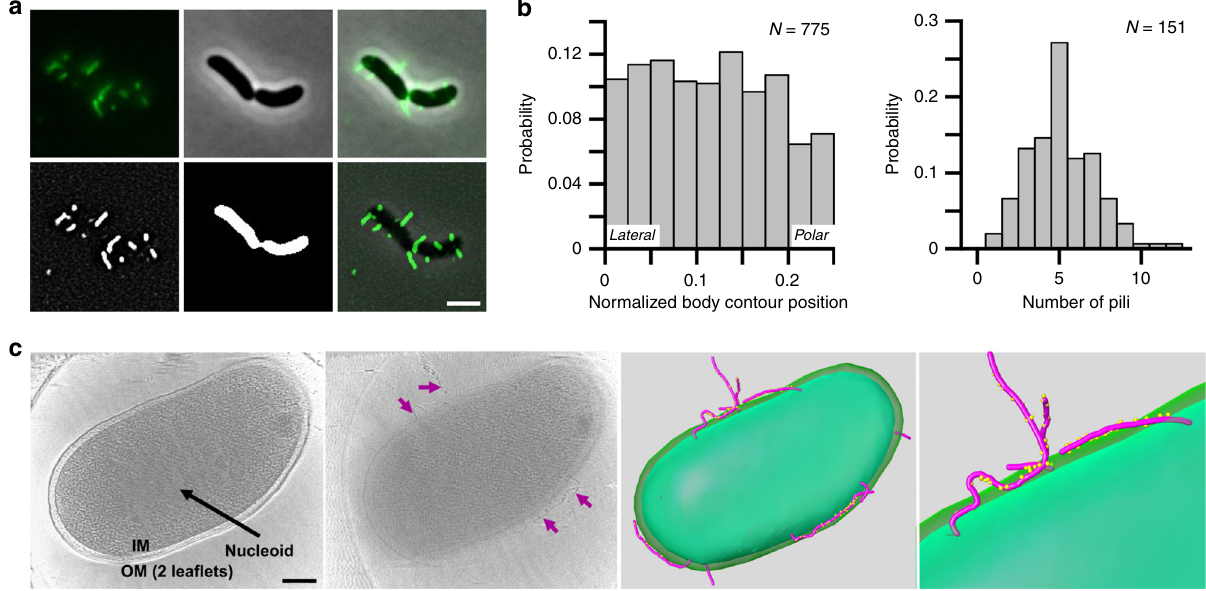
Fig. 1 MSHA pili are laterally localized along the cell body. a Representative images of surface-associated mshA T70C cells labeled with AlexaFluor 488 C 5 maleimide dye for visualization of MSHA pili. Raw images obtained are shown in: upper left panel — fl uorescence channel, upper middle panel — phase- contrast channel, and upper right panel — overlay. Processed images shown in: lower left panel — fi ltered- fl uorescence channel, lower middle panel — binary image of phase-contrast channel, lower right panel — overlay of fi ltered- fl uorescence and phase-contrast channels. Images representative of three independent analyses. Scale bar = 2 μ m. b Probability of pilus distribution ( n = 775 single cells) on the cell surface observed, and distribution of the average number of pili per cell ( n = 151 single cells) observed from agarose-pad associated cells. c Imaging the whole-cell suing Cryo-ET and 3D segmentation. Far Left Panel — The central slice of tomograms of mshA T70C whole-cell. Outer membrane two lea fl ets are visible. Nucleoid area is labeled in a white array. Middle Left Panel — Another slice from the same tomogram as shown in A, shows MSHA pili (marked with purple arrows) coated with the anti-MshA antibody. Middle Right Panel — 3D segmentation of far left and middle left panels, with MSHA pili (purple) coated with anti-MshA antibody (yellow dots). Far Right Panel — Zoom-in image of 3D segmentation to show antibody-coating on the surface of pili. Colors same as in middle right panel. 3D segmentation performed from a single Cro-ET analysis, with Cryo-ET analysis performed on multiple individual V. cholerae cells. Scale bar = 200